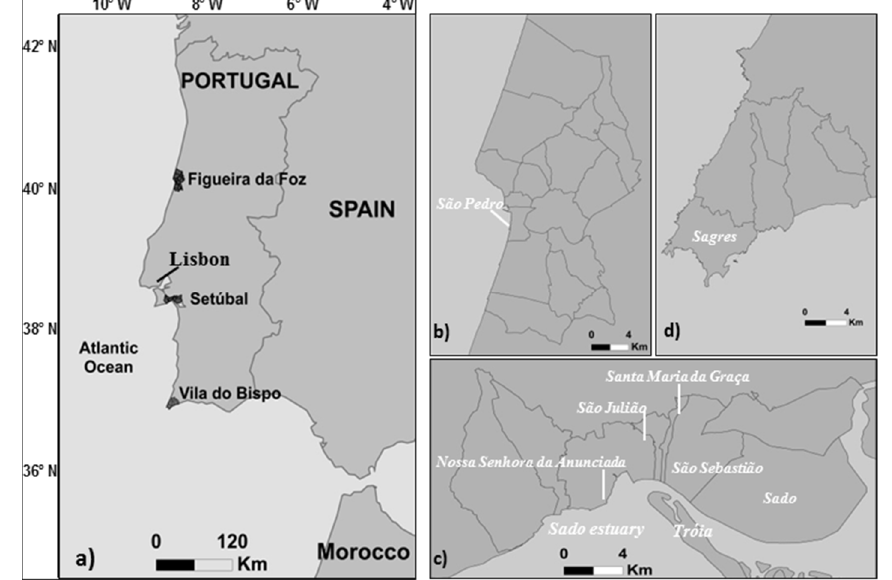
Figure 1. Location of the two study areas: ( a ) framework for Portugal; ( b ) municipality of Figueira da Foz; ( c ) municipality of Setúbal; and ( d ) municipality of Vila do Bispo. Table 1. Tsunami parameters for the studied municipalities [1]. Municipalities Run-up (m) Travel Time (min) Fatalities Figueira da Foz 36 Setúbal Vila do Bispo Note: (1) damage/fatalities due to earthquake, fire and